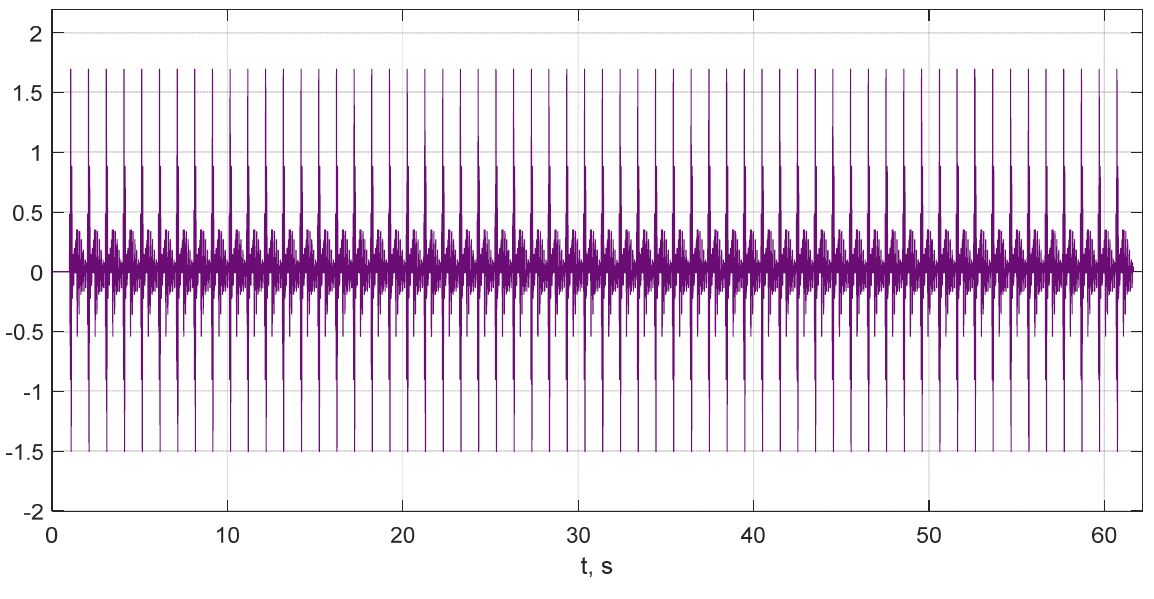
Figure 3. Theoretical sequence of SCG signals.